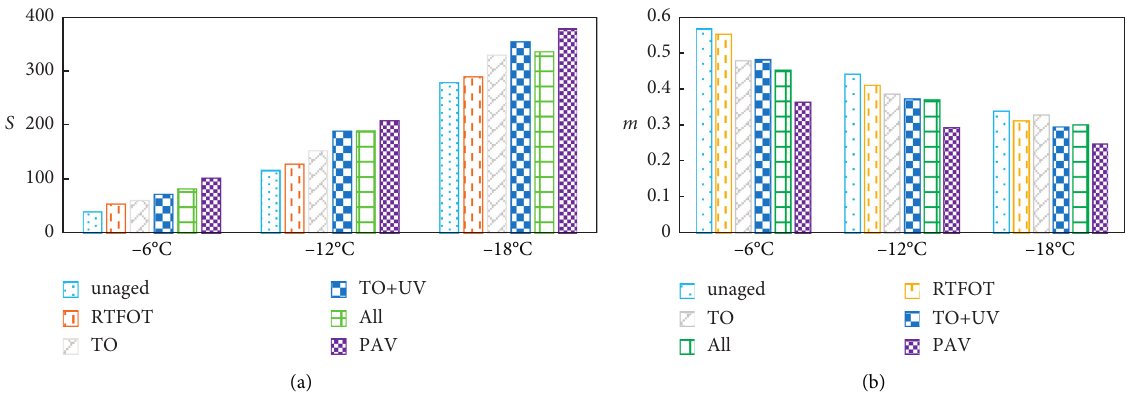
Figure 6: The stiffness modulus and creep rate of asphalt binder before and after aging. (a) Stiffness modulus S . (b) Creep rate m